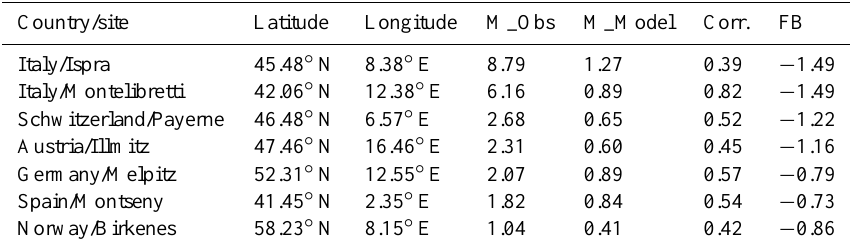
Table 3. Comparison of the mean (M) simulated OA concentrations (µgm − 3 ) with observations in Europe in sites from the EMEP network with available data for the year 2006. The model performances based on two-product approach for SOA formation are evaluated by statistic parameters (correlation coefficient (Corr.) and the fractional bias (FB)).